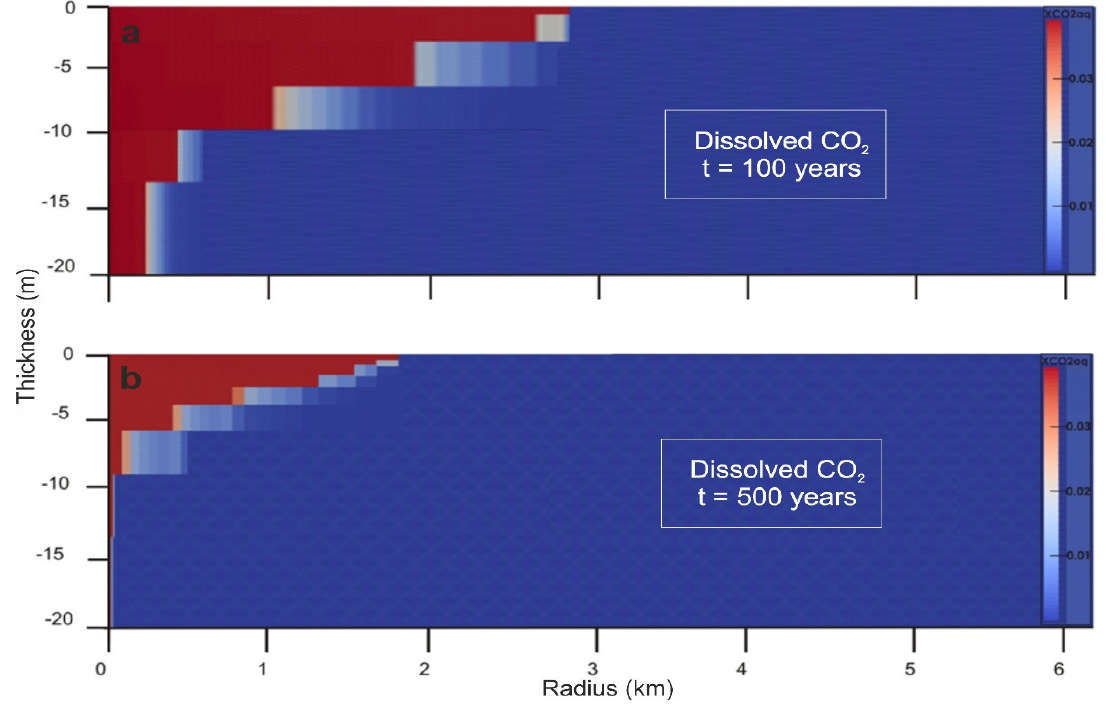
Figure 4. The amount of dissolved CO 2 in the reservoir 100 ( a ) and 500 ( b ) years after the injection ceased. The scale on the right shows the amount of CO 2